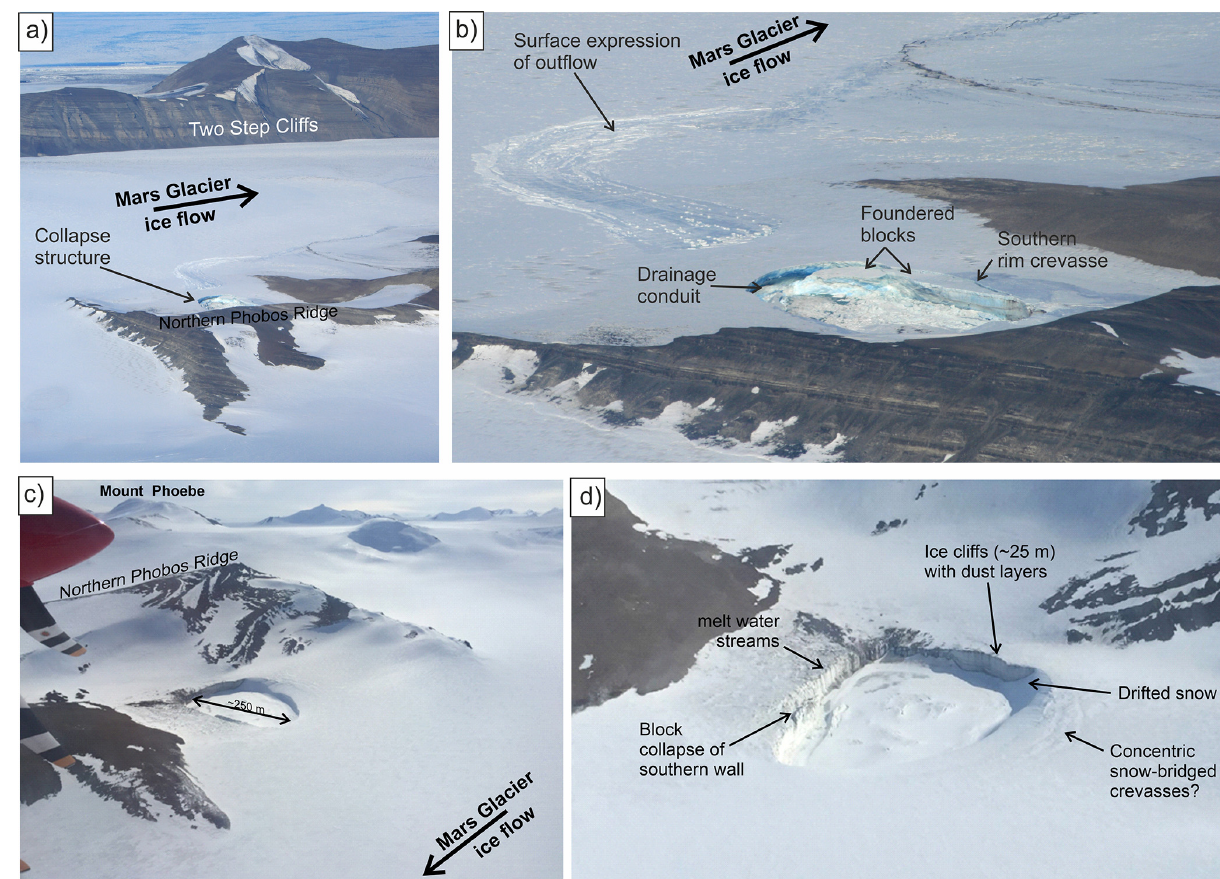
Figure 2. Oblique aerial photographs of the PICS. (a) Overview of northern Phobos Ridge, Mars Glacier and Two Step Cliffs showing the location of the PICS on 14 January 2011. (b) A closer view of PICS on the same date showing blocks of ice collapsing into the cavity forming ice cliffs, undercutting of the ice cliff in the (presumed) location of the subglacial drainage conduit, and the surface expression of the subglacial outflow channel heading down-glacier. Note the intact glacier ice between the assumed location of the PICS drainage conduit and the surface expression of the subglacial outflow channel on Mars Glacier. (c) PICS on 3 December 2018 looking northwest from Mars Glacier towards Phobos Ridge and Mount Phoebe beyond and (d) a closer view on the same date looking approximately southwest. Note the expansion of the feature (further block collapse on the southern side, formation of concentric crevasses on the northern side; left and right of image respectively), the presence of meltwater streams flowing into PICS via the ice cliffs and the absence of the surface expression of the subglacial outflow channel on Mars Glacier. Authors’ photographs (Neil Ross and Dominic A.